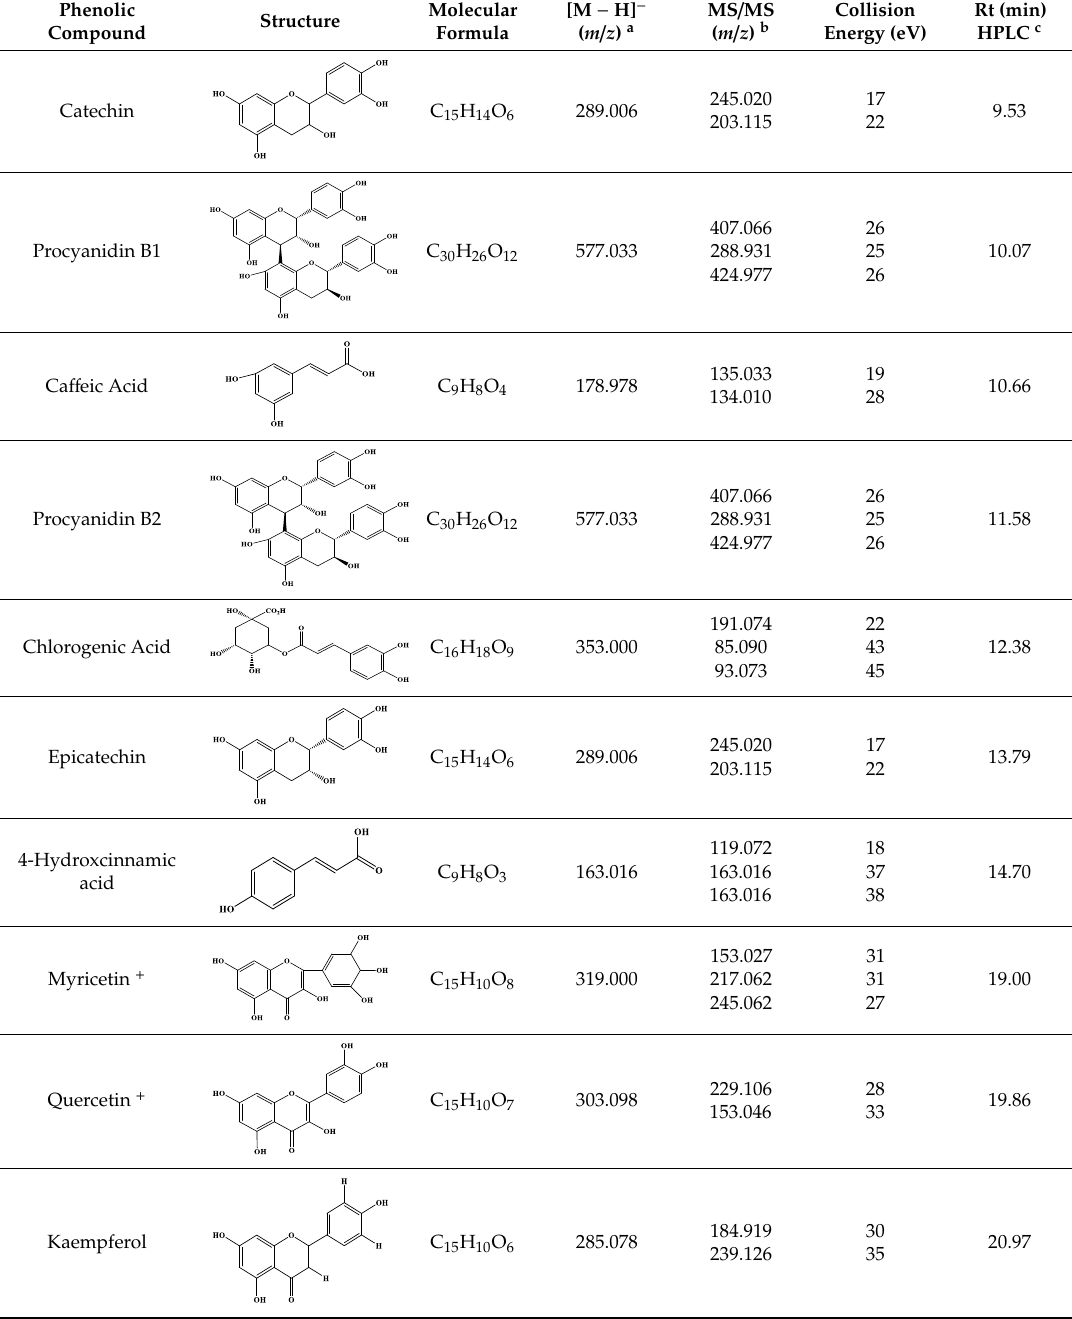
Table 1. Polyphenolic compounds and mass spectrometry variables found in blueberry pomace.